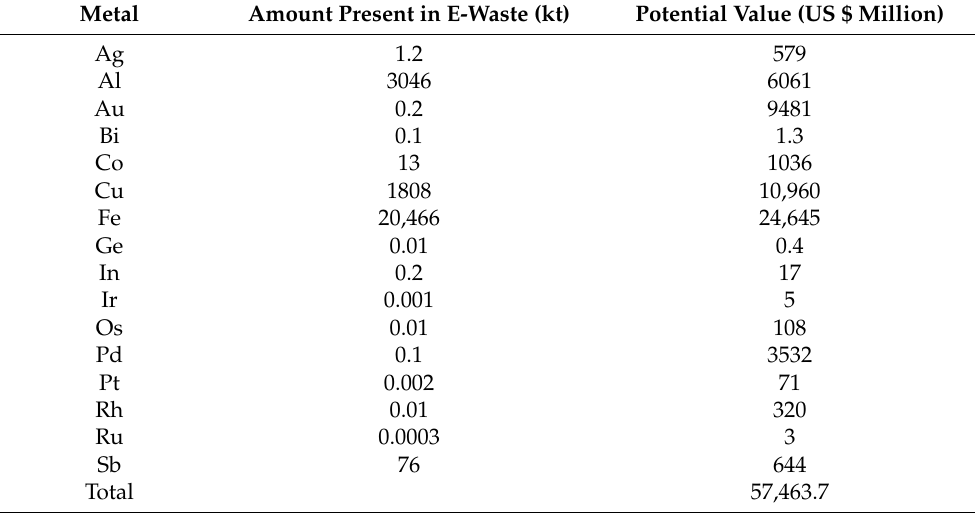
Table 1. Potential value of raw materials in e-waste generated globally in 2019